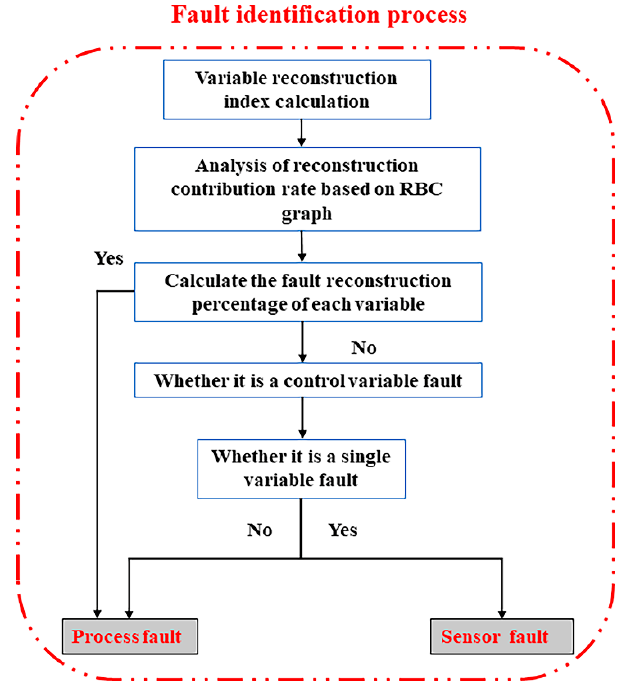
Figure 6. Fault identification process based on the RBC graph.